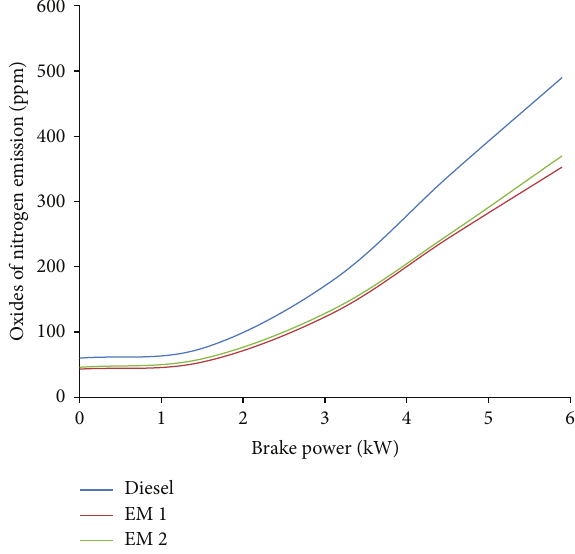
Figure 6: Brake power versus oxides of nitrogen emission.